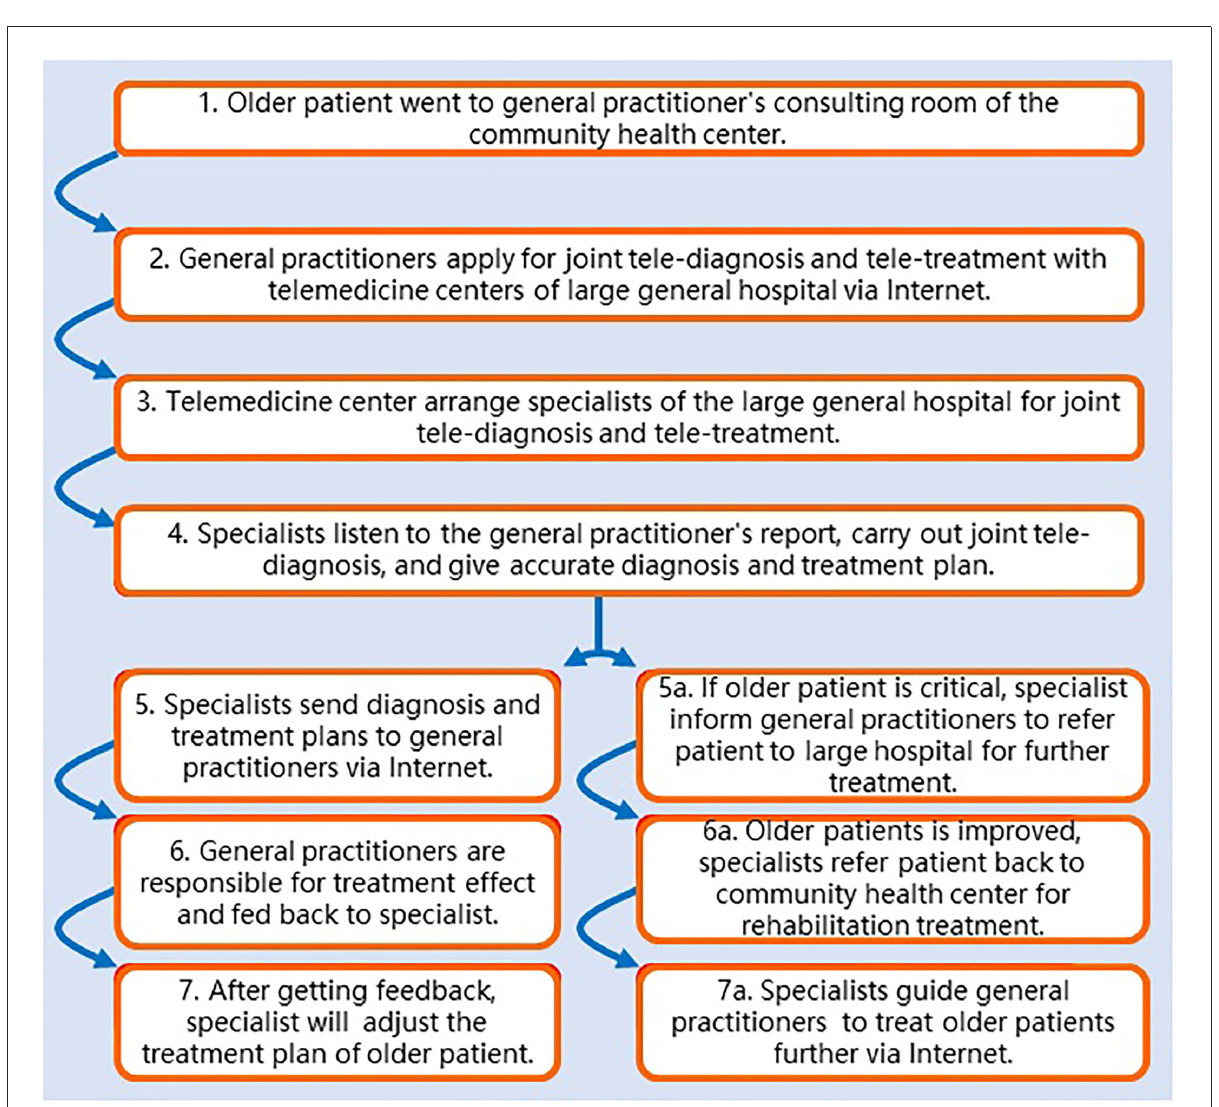
disease, etc. can receive tele-diagnosis and tele-treatment via